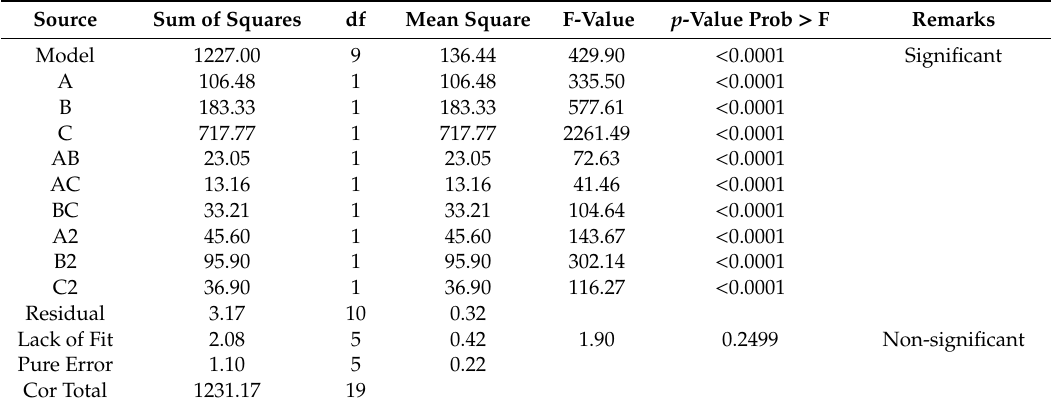
Table 4. ANOVA for response surface quadratic model on